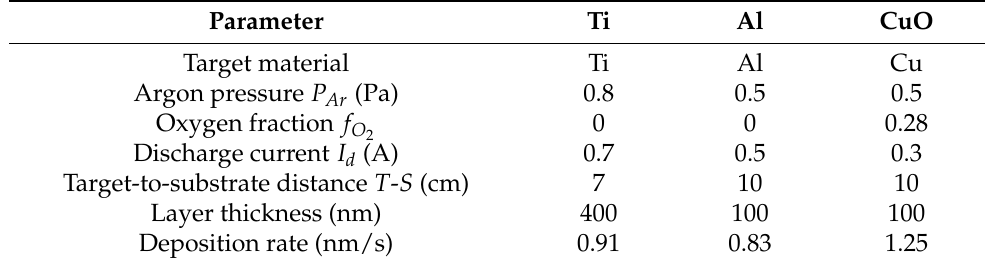
Table 1. Deposition conditions of the different used materials i.e., the titanium contact layer, and the Al and CuO layers to form the bilayer. The oxygen fraction is calculated as the ratio of the oxygen partial pressure and the total pressure.